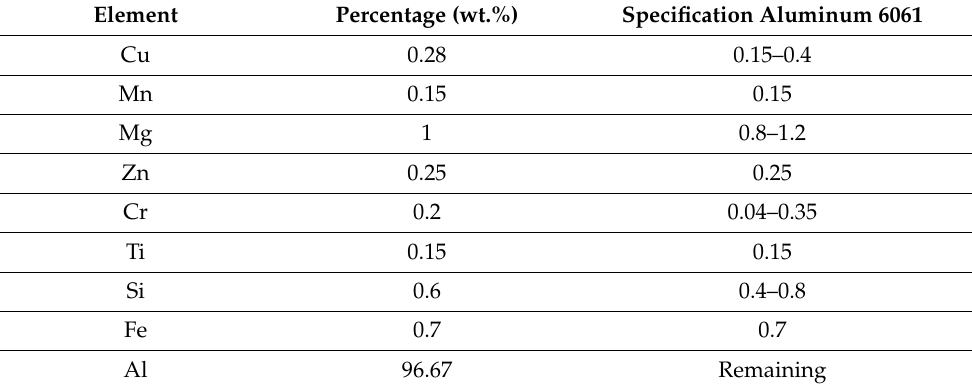
Table 1. Chemical composition of Al 6061 [22].